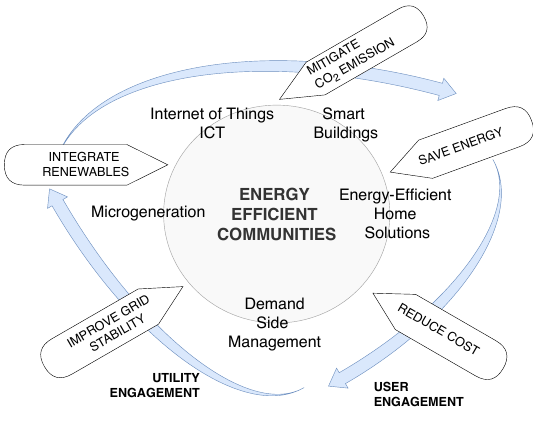
Figure 1. Energy-efficient communities’ main players and